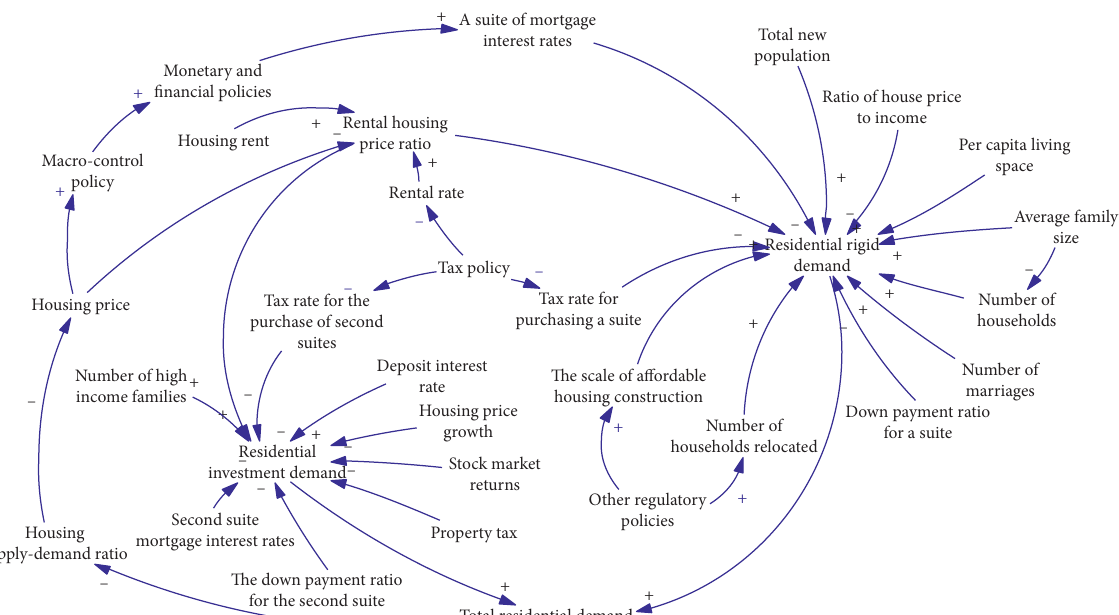
Figure 2: Causality diagram of housing demand